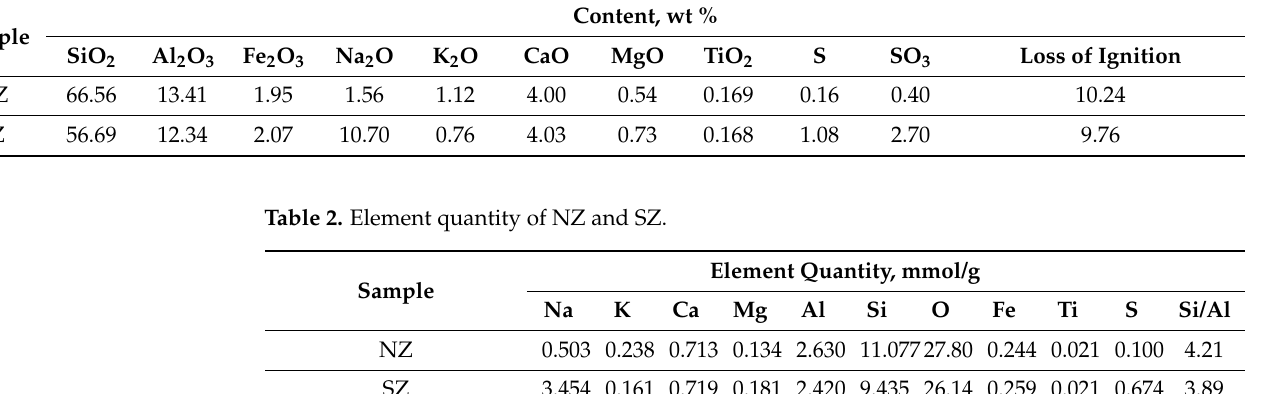
Table 1. Chemical composition of natural zeolite (NZ) and sulfur-impregnated zeolite (SZ). Sample